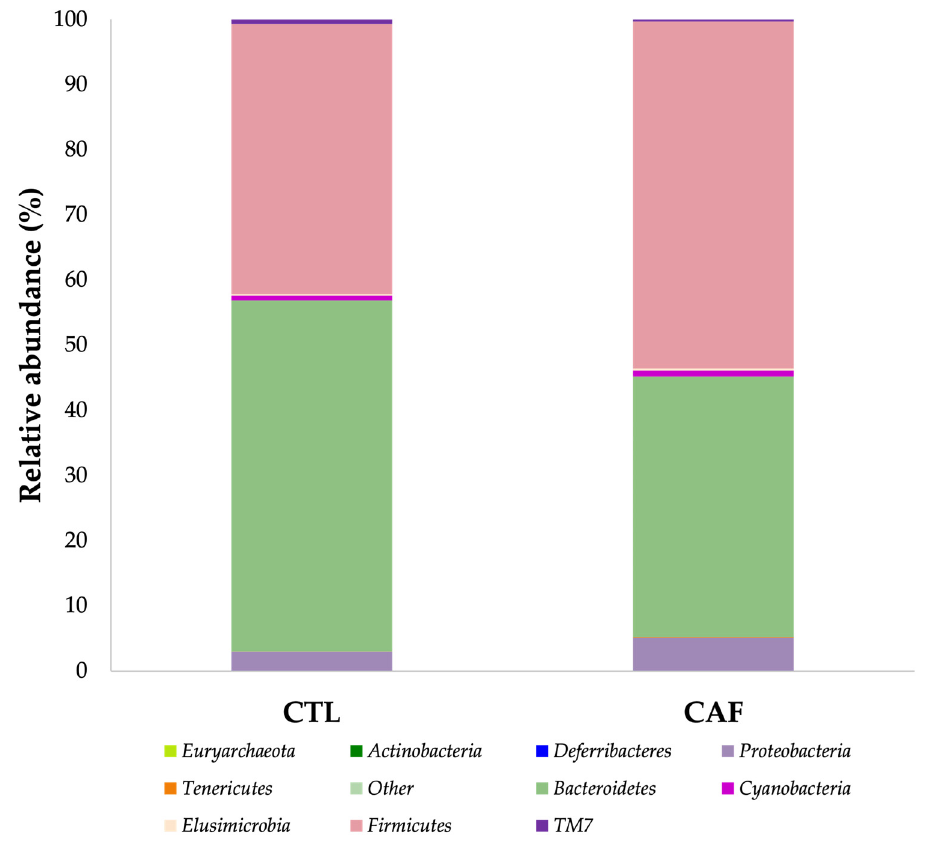
Figure 3. Relative abundance (>0.05%) of bacterial phyla in gut microbiota of male Wistar rats. CTL: control group; CAF: cafeteria group.